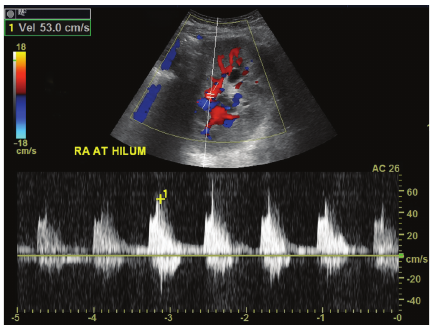
Figure 2: Power Doppler ultrasound demonstrates no internal vascularity within the enlarged hyperechoic left lower quadrant renal allograft raising concern for renal artery thrombosis and impending infarct. Note the moderate dilatation of the allograft collecting system (arrow).